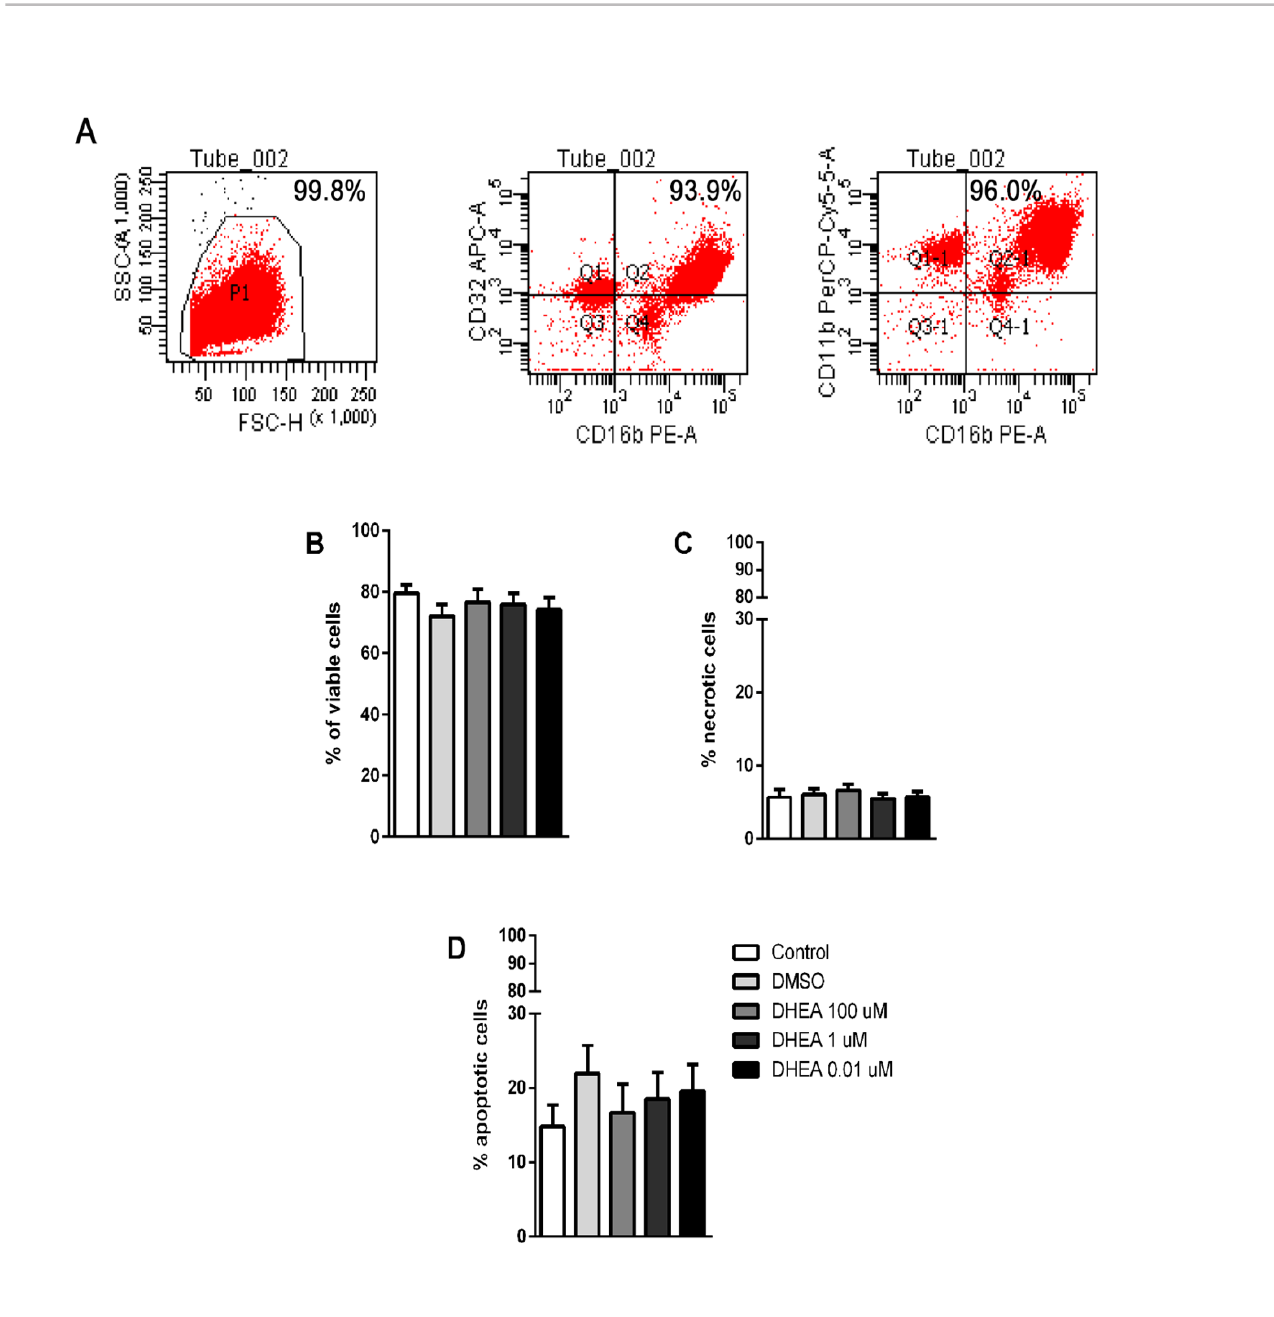
FIGURE 1 – Purity and viability of neutrophils. PMN were isolated from peripheral blood of healthy men using a Percoll density gradient. (A) After separation, the isolated cells (5 x 105) were incubated with antibodies against CD11b, CD16 and CD32 and analyzed by flow cytometry to verify the purity. Once isolated, neutrophils were treated with DHEA in the concentrations of 100 μM, 1 μM and 0.01 μM for 1 hour. (B) The percentage of viable cells (anexin-/PI-), (C) necrotic cells (PI+) and (D) apoptotic cells (annexin+/PI-) were analyzed by flow cytometry. Data express the Mean (SD) of 4 independent experiments performed on different days, with cells from 8 different donors.